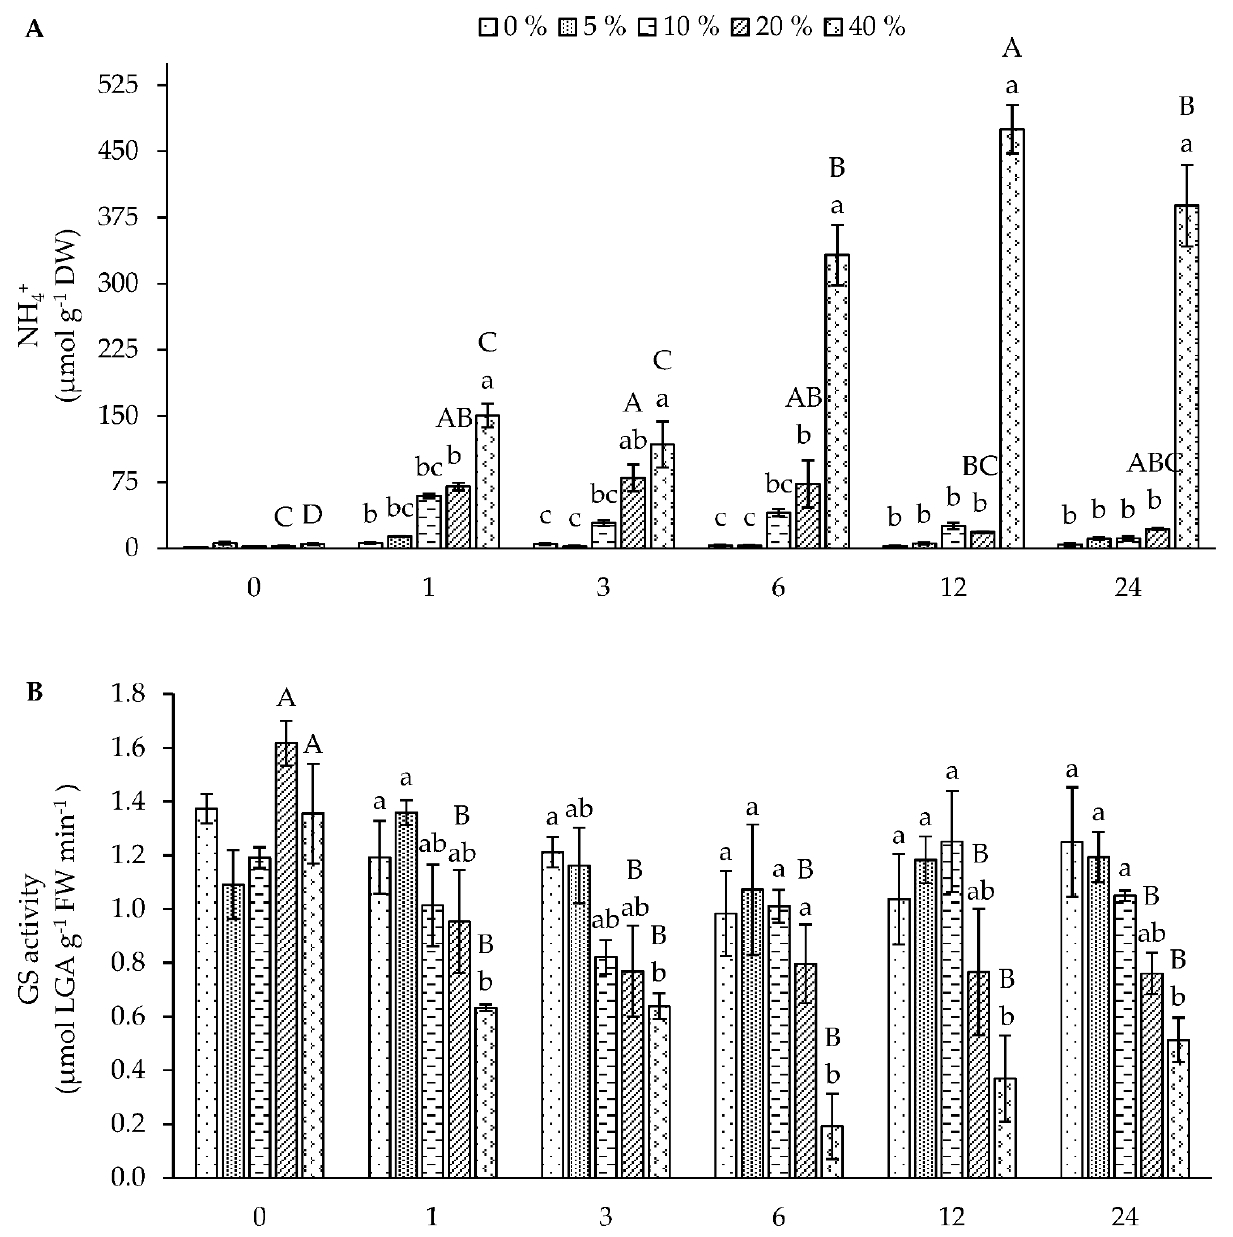
Figure 5. Ammonium concentration (NH 4+ ) ( A ) and glutamine synthetase (GS) activity ( B ) of the youngest and second youngest fully expanded leaves of wheat (cv. Amaretto) at 0, 1, 3, 6, 12, and 24 h after application of UAN solutions with increasing N concentrations, namely 0, 5, 10, 20, and 40% N. Data are the means of three independent biological replicates ± standard error. Small letters indicate a difference between N treatments at each application time, and capital letters indicate a difference in the application times for each N treatment, according to Tukey’s post hoc test ( p < 0.05). Ammonium assimilation in plants is catalyzed by the GS enzyme, incorporating NH 4+ into glutamine (Gln). Unexpectedly, the GS activity dropped in plants sprayed with 20 and 40% N treatments already at 1 HAFNf (Figure 5B), but remained similar to the control treatment in the 5 and 10% N treatments (Figure 5B). The GS activity remained low in the 20 and 40% N treatments during the experimental period. In order to decipher the decline in GS activity, the individual activities of the GS isoenzyme GS1 (localized in the cytosol) and GS2 (localized in the chloroplast) were also evaluated at 6 HAFNf in the